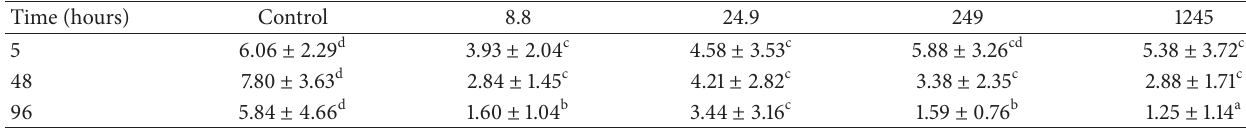
Table 3: Mean values ( ± SD) of total hemocyte concentrations (10 6 cells mL − 1 ) of L. vannamei exposed to four concentrations ( 𝜇 gL − 1 ) of